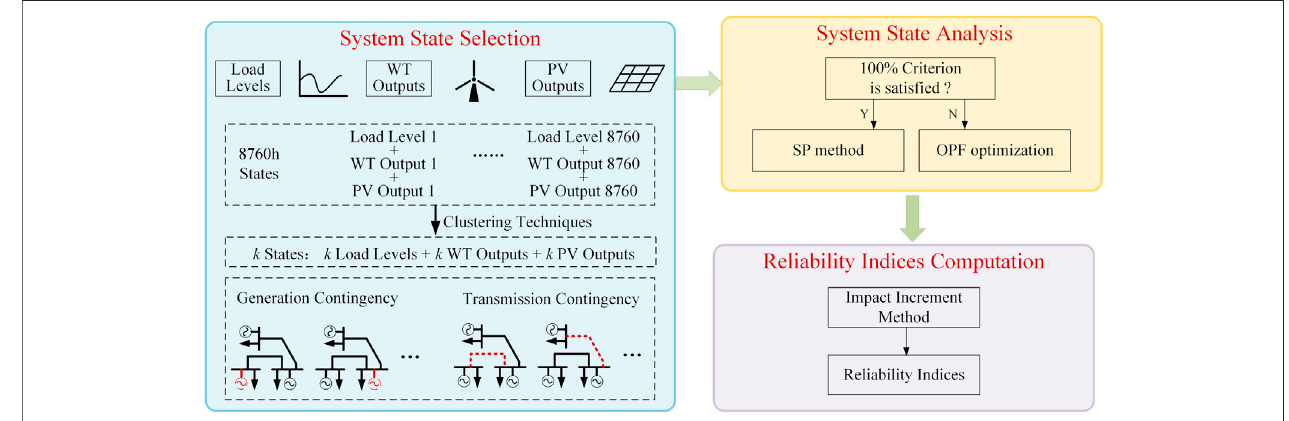
FIGURE 1 | The framework of the proposed